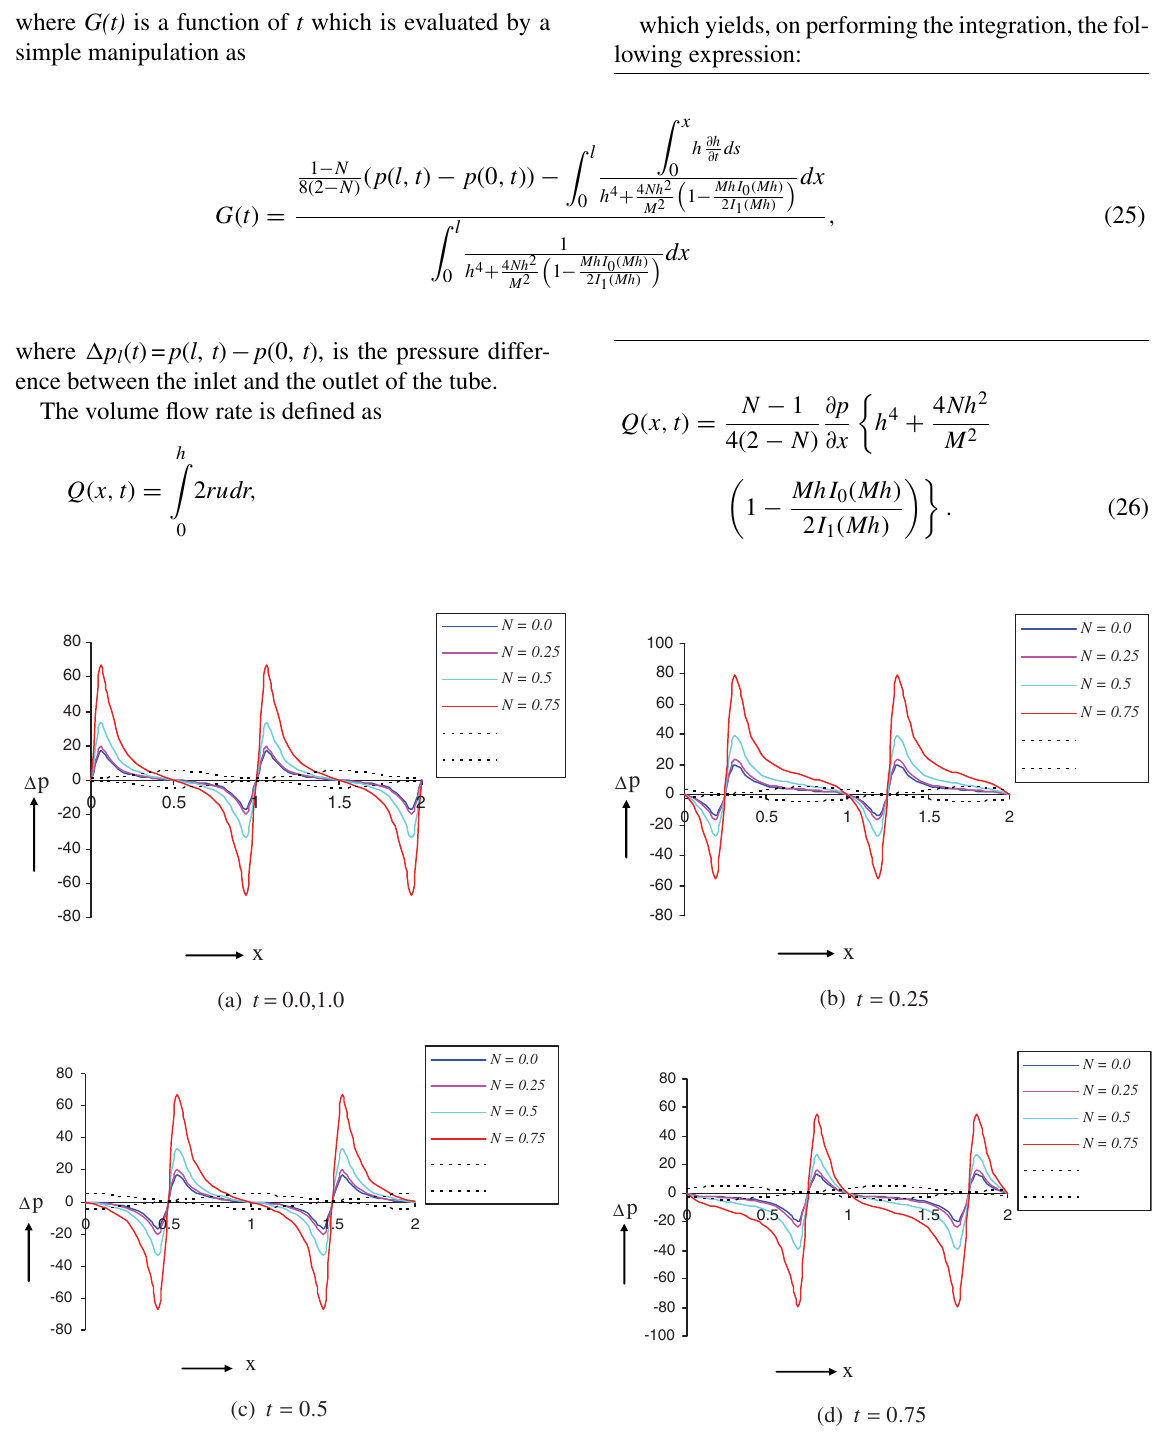
Fig.2. PressuredistributionalongtheaxialdistanceofthefinitelengthtubeatfivetimeinstantsbasedonEq.(23).Dottedlines( ······ )represent the position of wave, whereas continuous lines (—) represent the pressure distribution for N =0.0–1.0, φ =0.9, N =1.0 and l